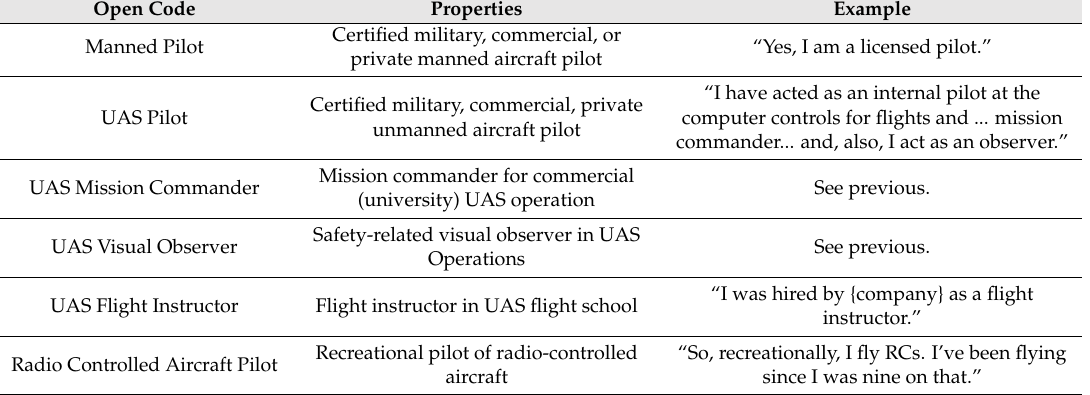
Table A1. Research Question: What roles/duties have participants carried out in the context of manned and unmanned aircraft operations?